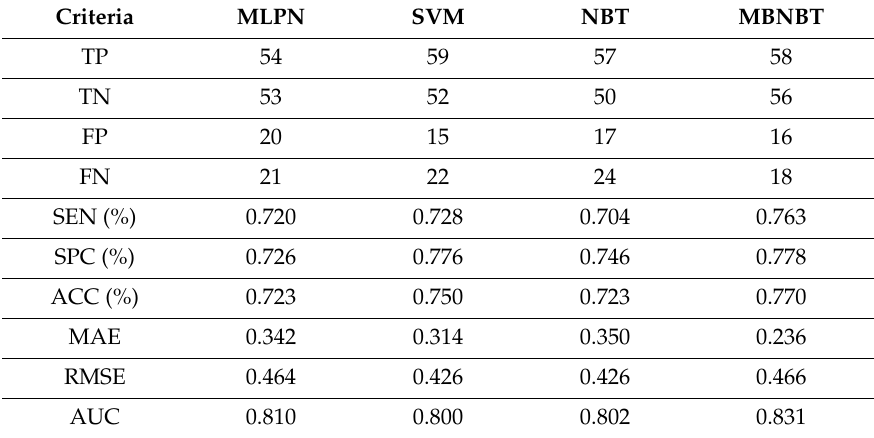
Figure 5. Modelling results based on the RMSE error value in the training and validation phases. Table 2. Model performance using the validation